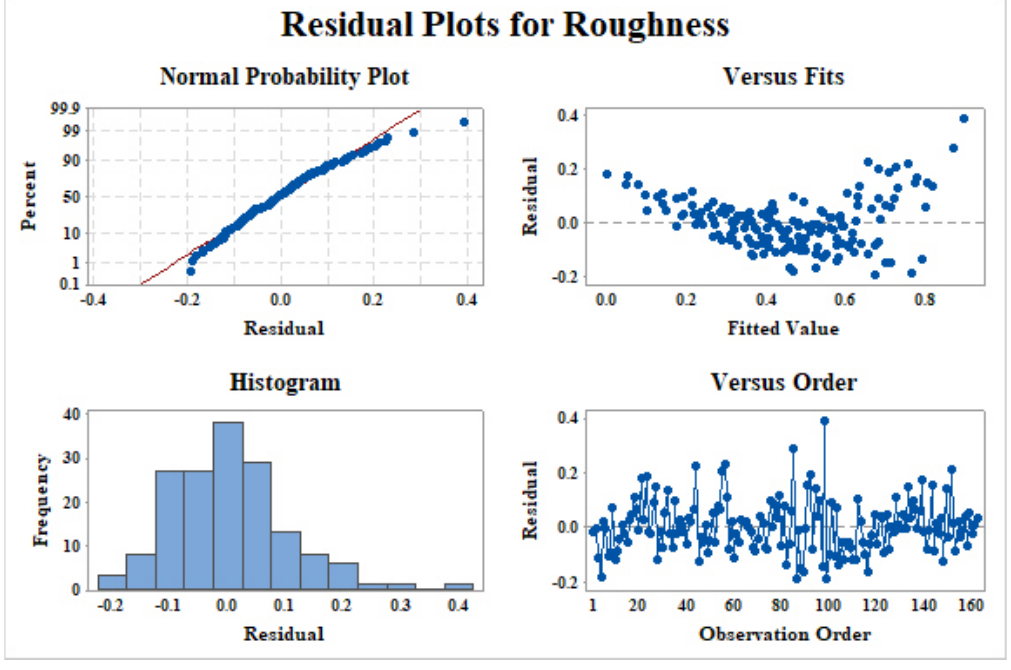
Figure 3. Residual plots for roughness.